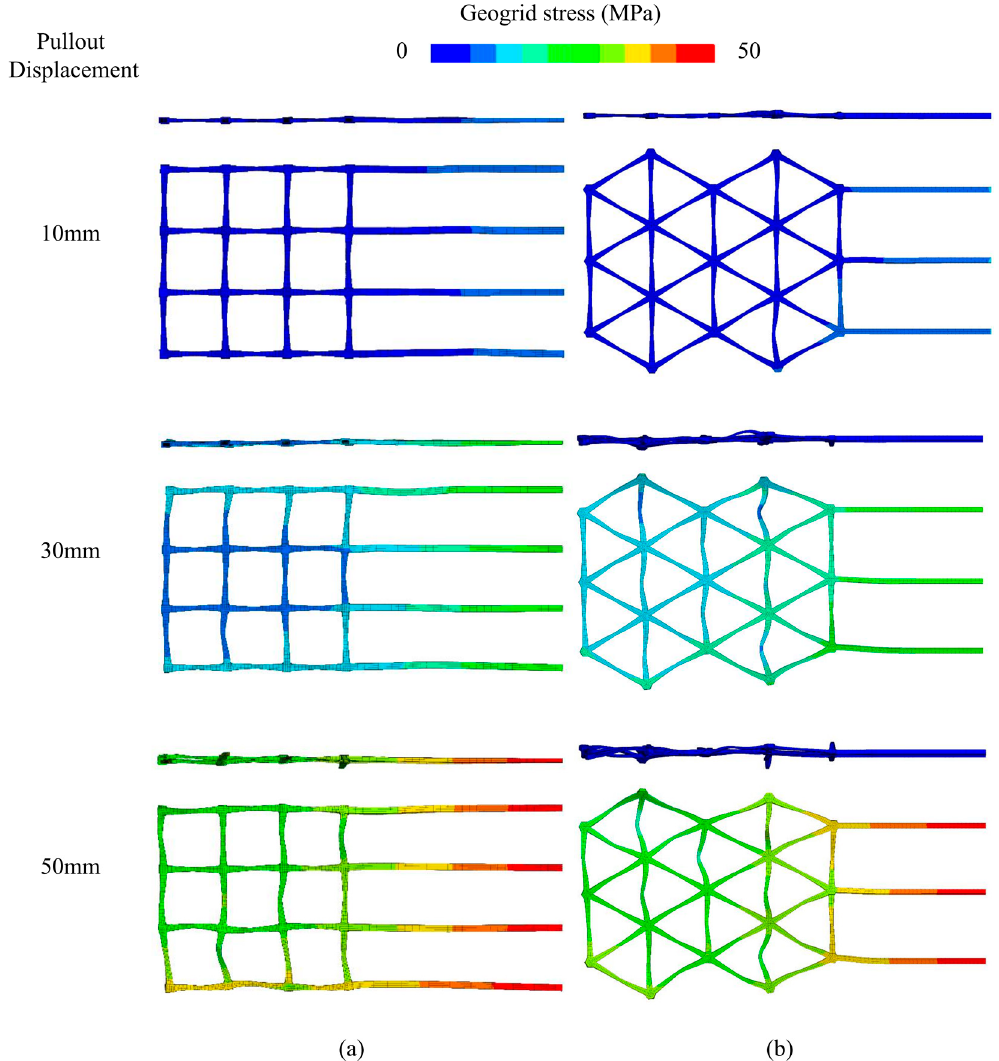
Figure 9. Geogrid deformation at different pullout displacements: ( a ) biaxial geogrid and ( b ) triaxial geogrid .